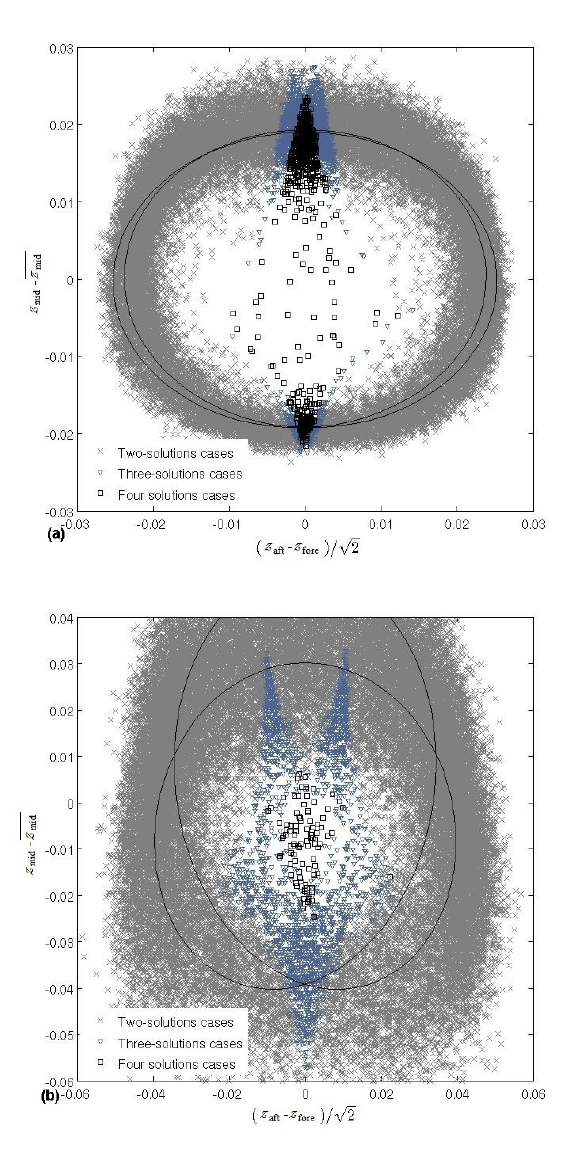
Fig. 1. Intersection of the cone with plane z fore + z aft = 2 z ref for (a) WVC number 1 and (b) WVC number 41, for a value of z ref cor- responding approximately to a speed of 8ms − 1 . z fore and z aft rep- resent the fore- and aft-beam backscatter measurements transforma- tion in z-space (see Eq. 2). Triplets within a distance of ± 0.01 z ref from the mentioned plane are plotted. The cross, triangular and square markers in different greyscale represent the triplets with 2, 3 and 4 wind solutions